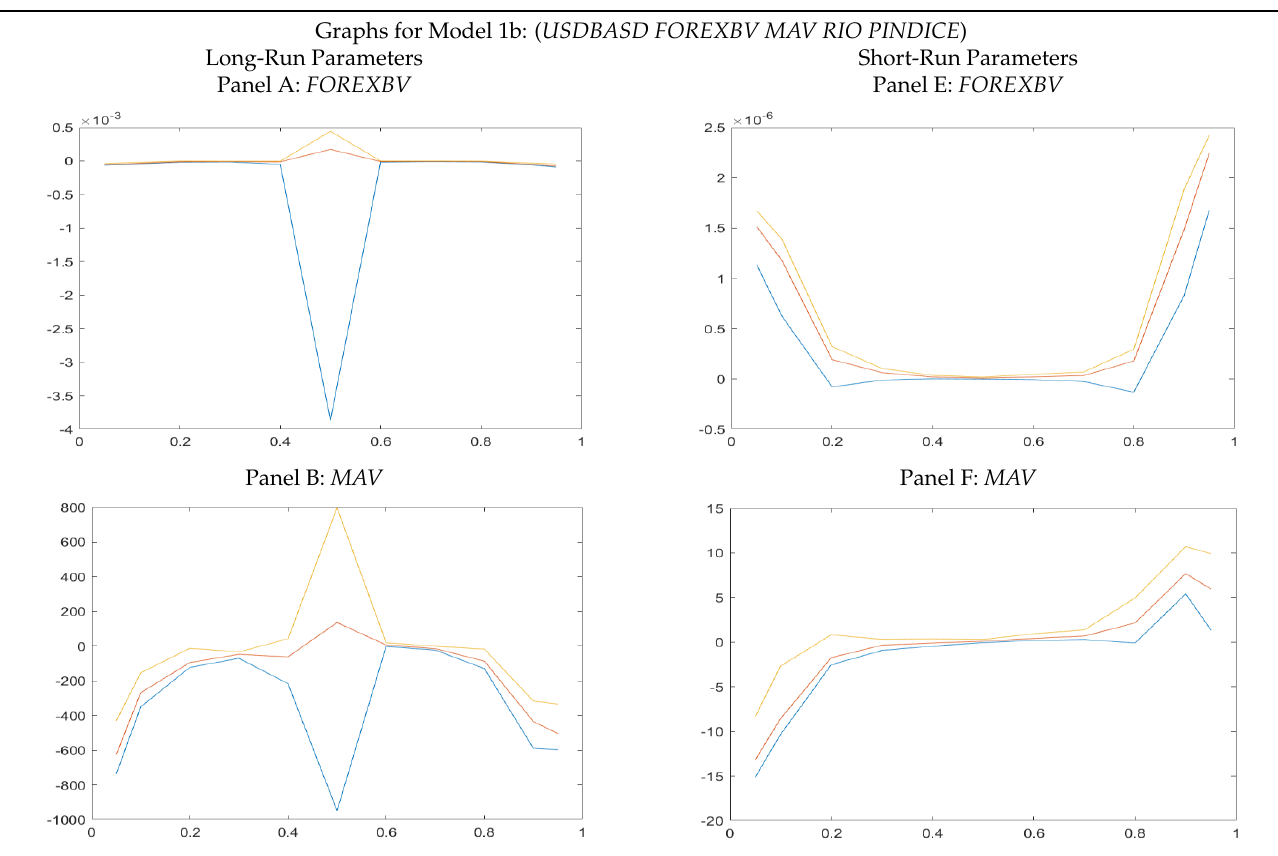
Table 6. Graphs for Model 1b: ( USDBASD FOREXBV MAV RIO PINDICE ), for Model 2b: (